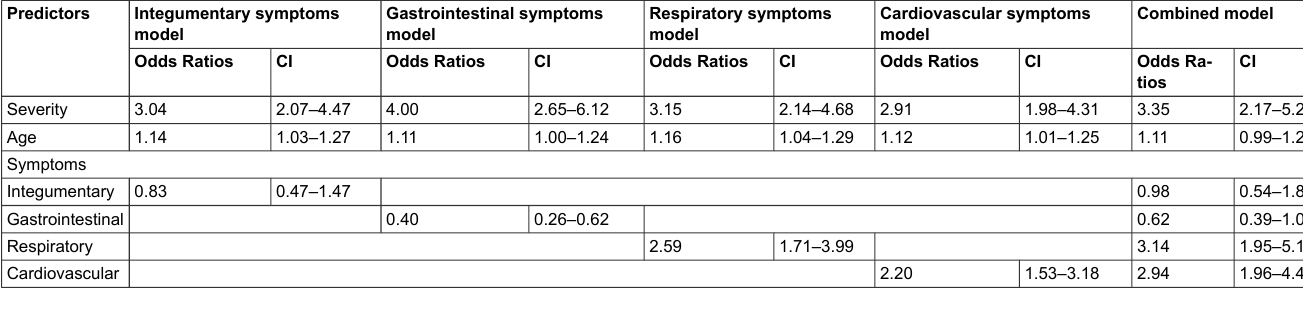
Table 3: Predictors of epinephrine